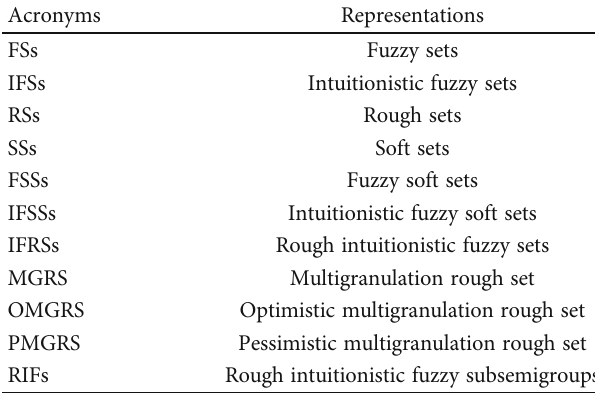
Table 1: List of